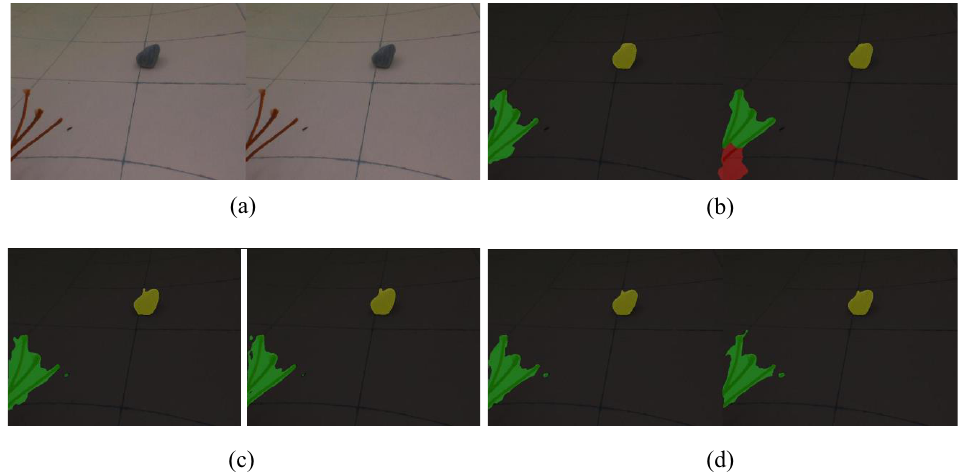
Figure 7. The results of binocular camera input with different resolutions. ( a ) Input image; ( b ) results of stitched binocular camera input; ( c ) results of binocular camera input as two images; ( d ) results of binocular camera input in full-size